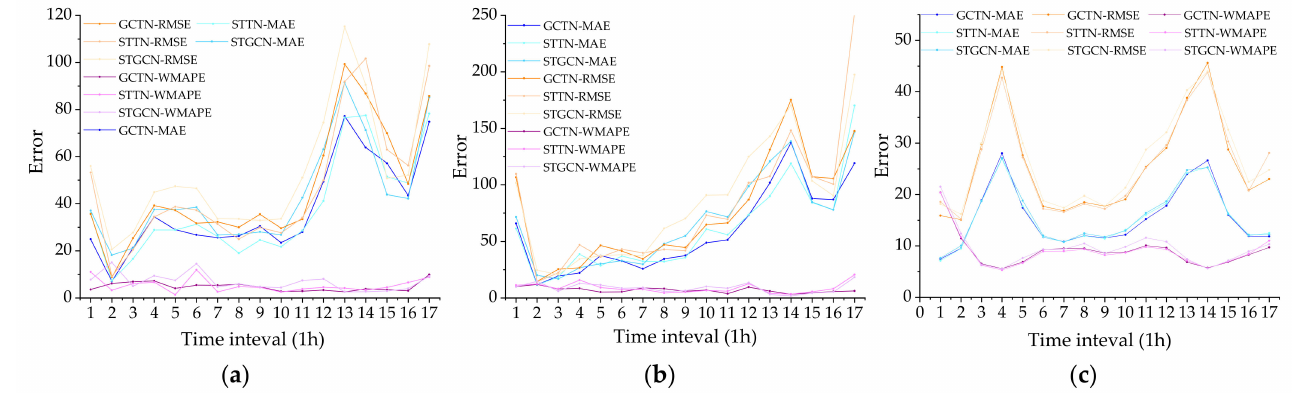
Figure 15. Inflow prediction performance of different times in the working day, with each time interval of 60 min. ( a ) Xujiahui station; ( b ) People’s Square station; ( c ) All stations.